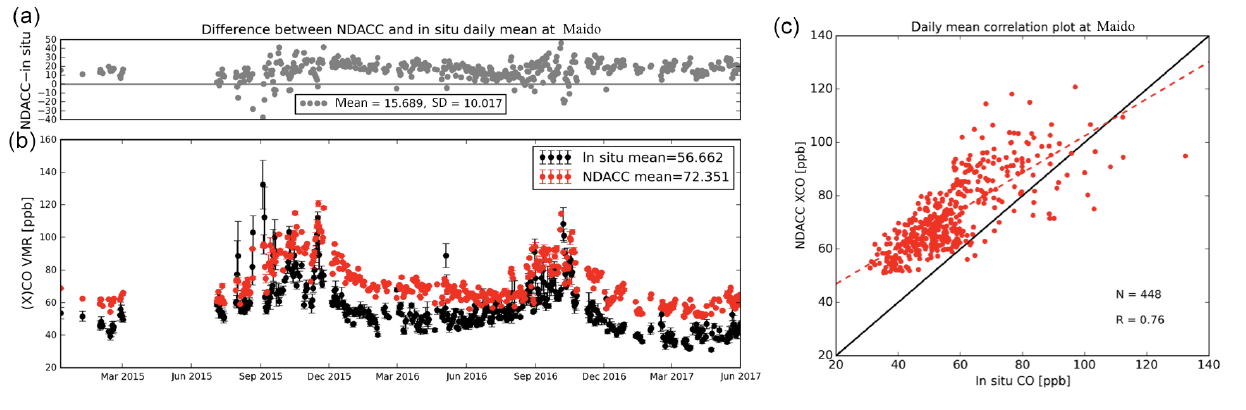
Figure 6. The time series of the daily means and standard deviations from FTIR (NDACC) X CO and daytime in situ CO measurements at Maïdo, in addition to the absolute difference (unit: ppb) between them (left lower and top, respectively) and their correlation (right).